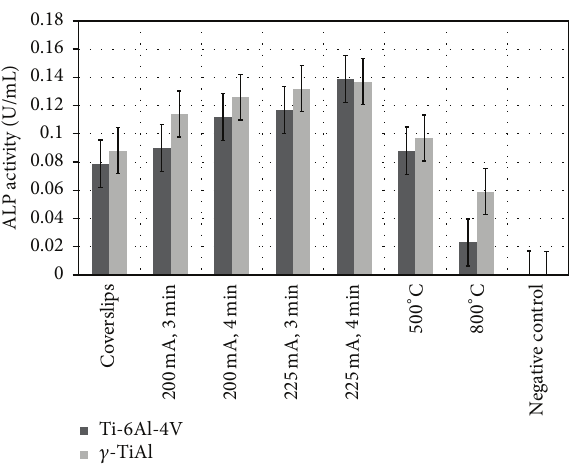
Figure 4: Alkaline phosphatase activity on thermally oxidized and MAO treated Ti-6Al-4V and 𝛾 -TiAl alloys. ALP activity on positive control (glass coverslips) and untreated Ti alloys is also